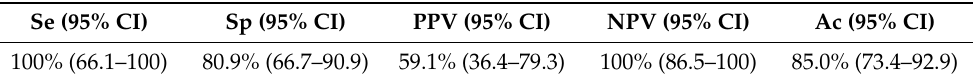
Table 4. Diagnostic accuracy of type III and IV intraepithelial papillary capillary loops by narrow band imaging to determine the possibility of OSCC lesion as a result of incisional